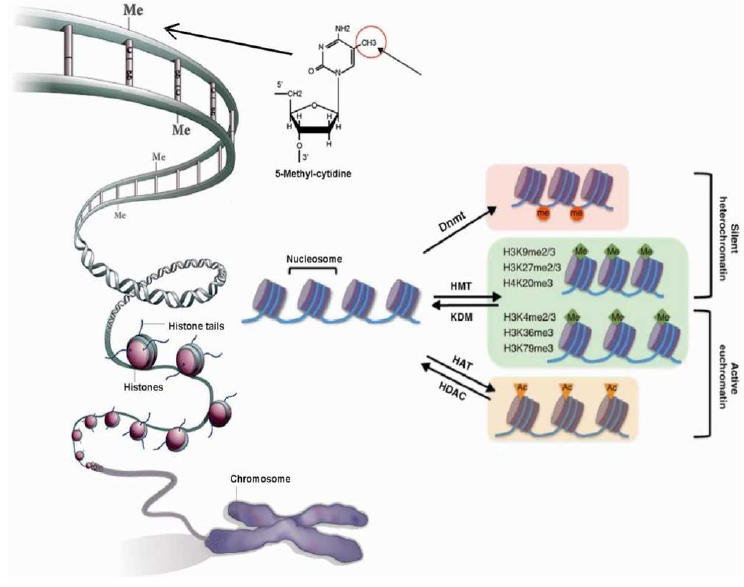
Figure 1. Diagrammatic representation of epigenetic mechanisms namely DNA methylation and chromatin modifications [14]. chromatin modifications